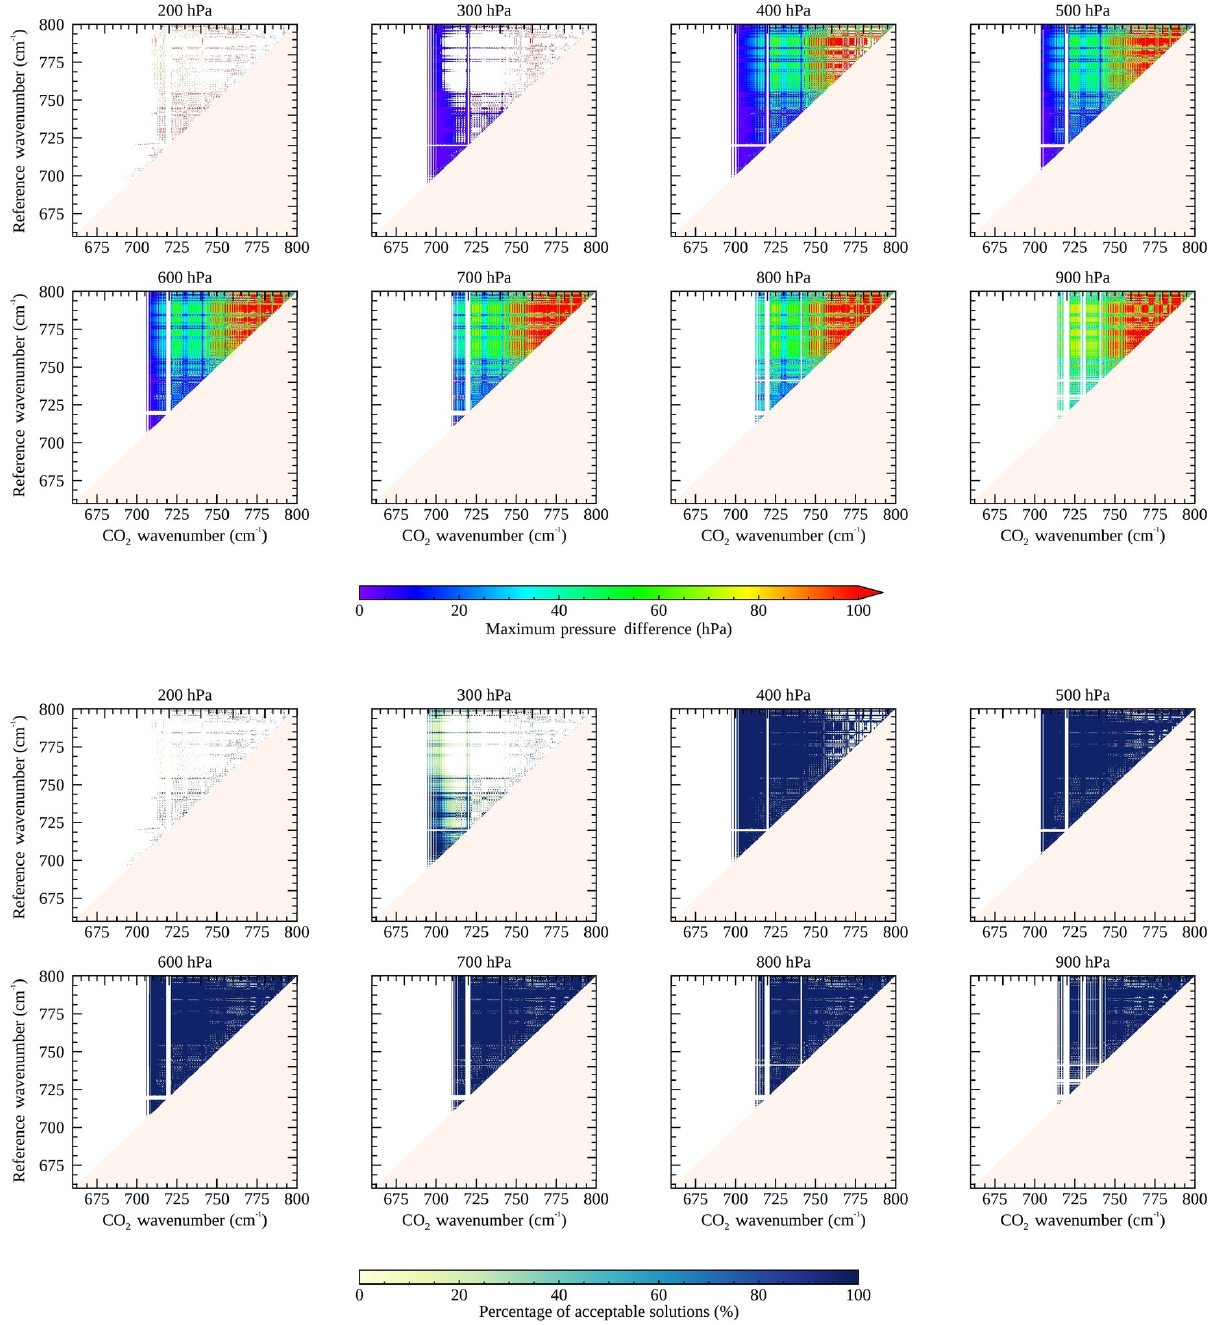
Figure A3. Same as Fig. A1 for a mid-latitude night